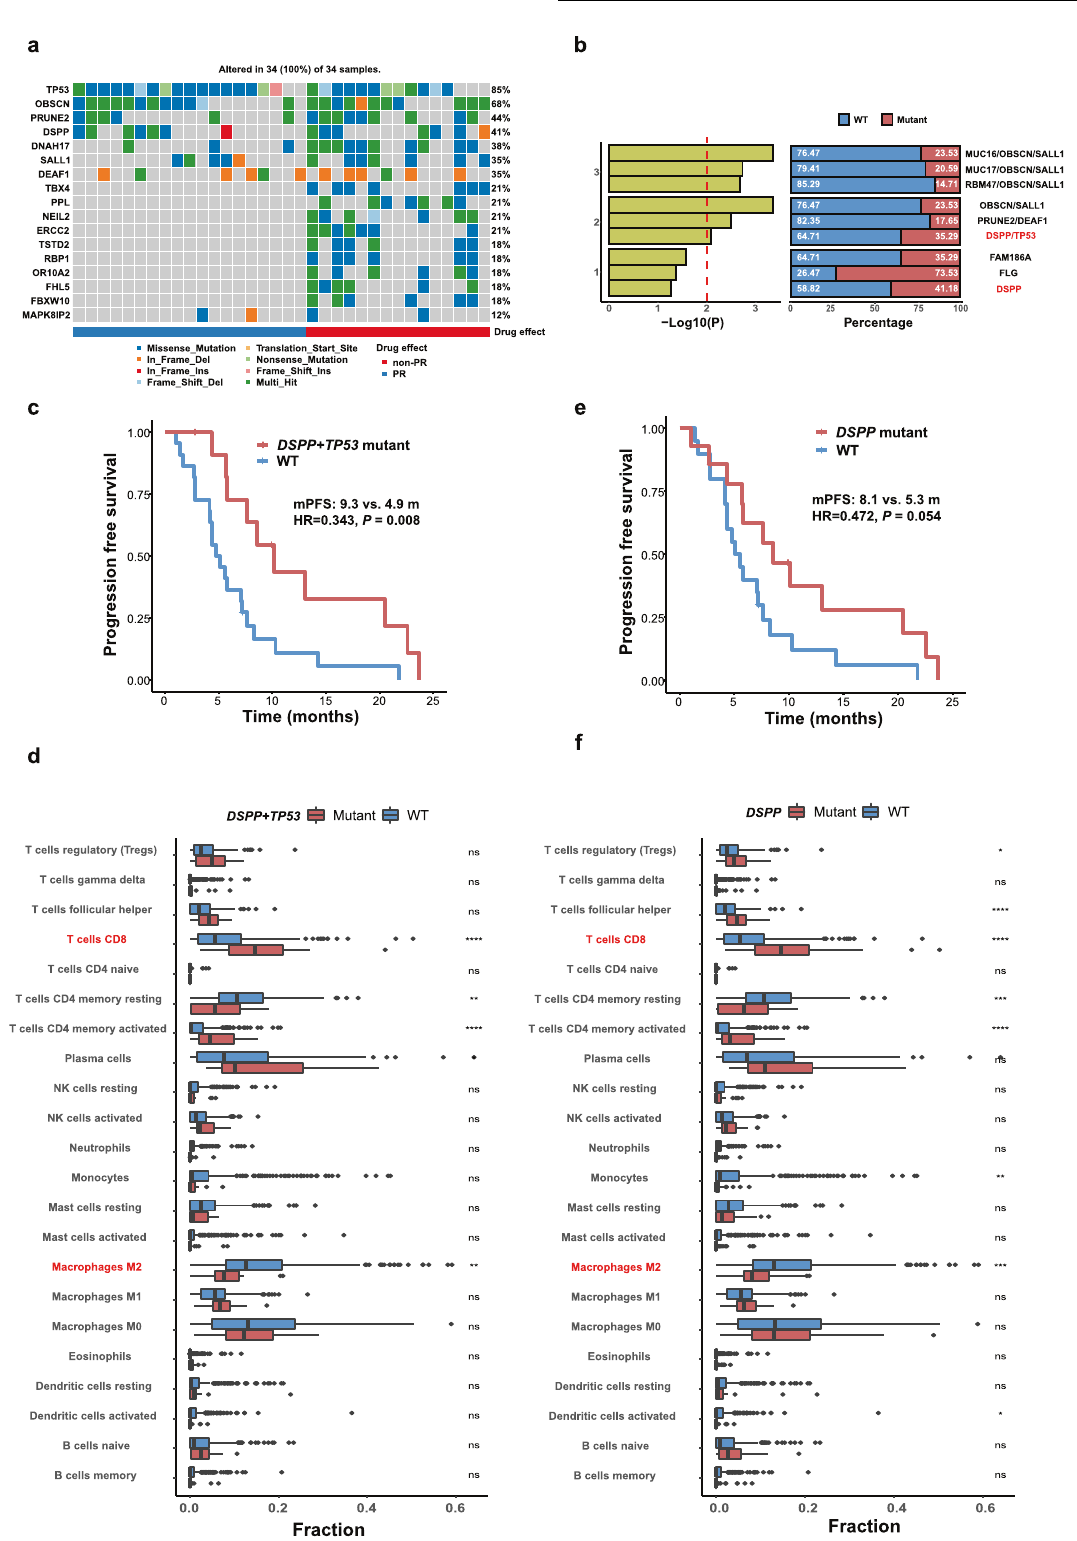
Fig. 3 Whole-exome sequencing. a Highlight mutated genes color-coded by the type of mutations in experimental samples. b According to the P value of PFS between groups, the top three combinations with different gene numbers were selected. The red line in the left panel shows the threshold of the fi lter. The white number on the barplot in the right panel represents the proportion of the corresponding sample in the total population. c Progression-free survival in patients with DSPP + TP53 comutation versus wild type (log-rank test). d Immune in fi ltration of DSPP + TP53 comutation versus wild type from EGFR- mutant samples obtained from TCGA (Wilcoxon signed-rank test). e Progression-free survival in patients with DSPP mutation versus wild type (log-rank test). f Immune in fi ltration of DSPP mutation versus wild type from EGFR mutant samples obtained from TCGA (Wilcoxon signed-rank test). PFS progression free survival; HR hazard ratio; * P < .05, ** P < .01, ** *P < .001, **** P < .0001 Signal Transduction and Targeted Therapy (2021)